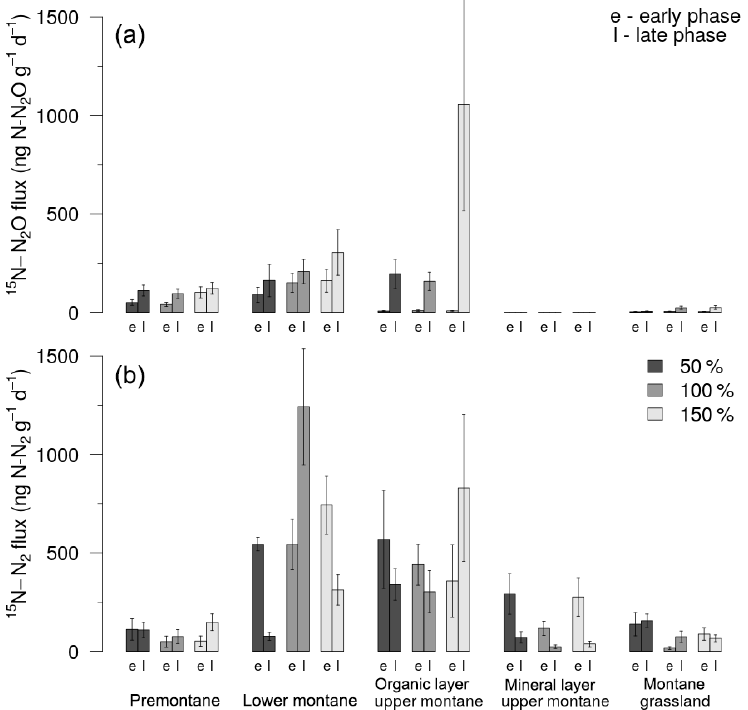
Figure 5. (a) 15 N–N 2 O flux and (b) 15 N–N 2 flux during the early ( ≤ 24h) and late ( > 24h) incubation phases of the NO − iment. Results from the + 50% NO − addition are shown in dark grey, while data from the + 100 and + 150% treatments are shown in mid 3 grey and light grey, respectively. The bar charts show means and standard